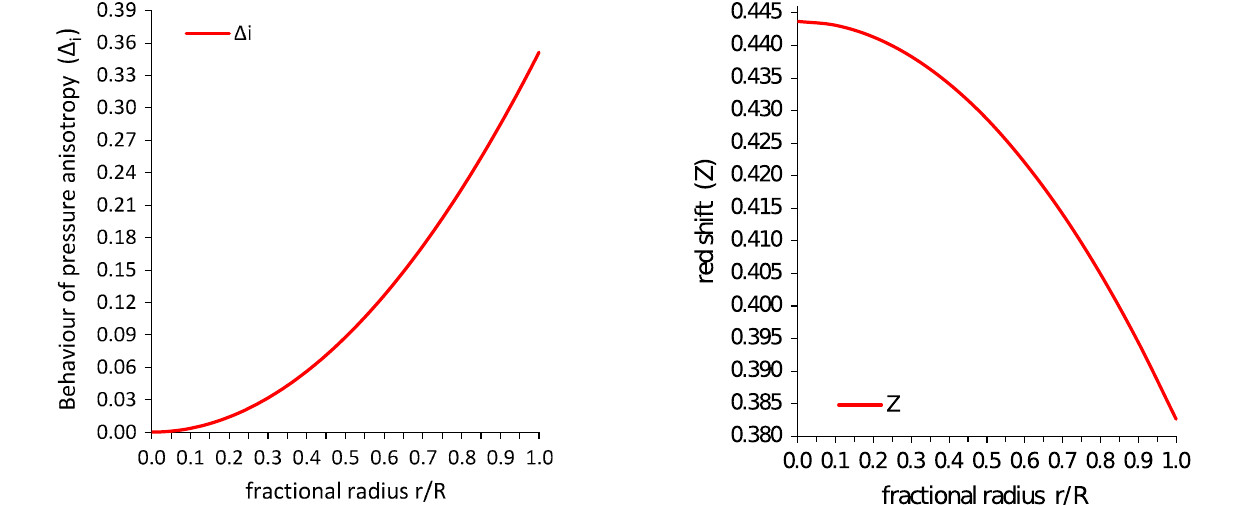
Fig. 13 Redshift of the stellar model with respect to fractional radial distance ( r / R ) for RX J 1856-37. For plotting this figure we have employed the same data set of numerical values as used in Figs. 1, 2, 3, 4, 5, 6, 7, 8, 9, 10, 11 and 12